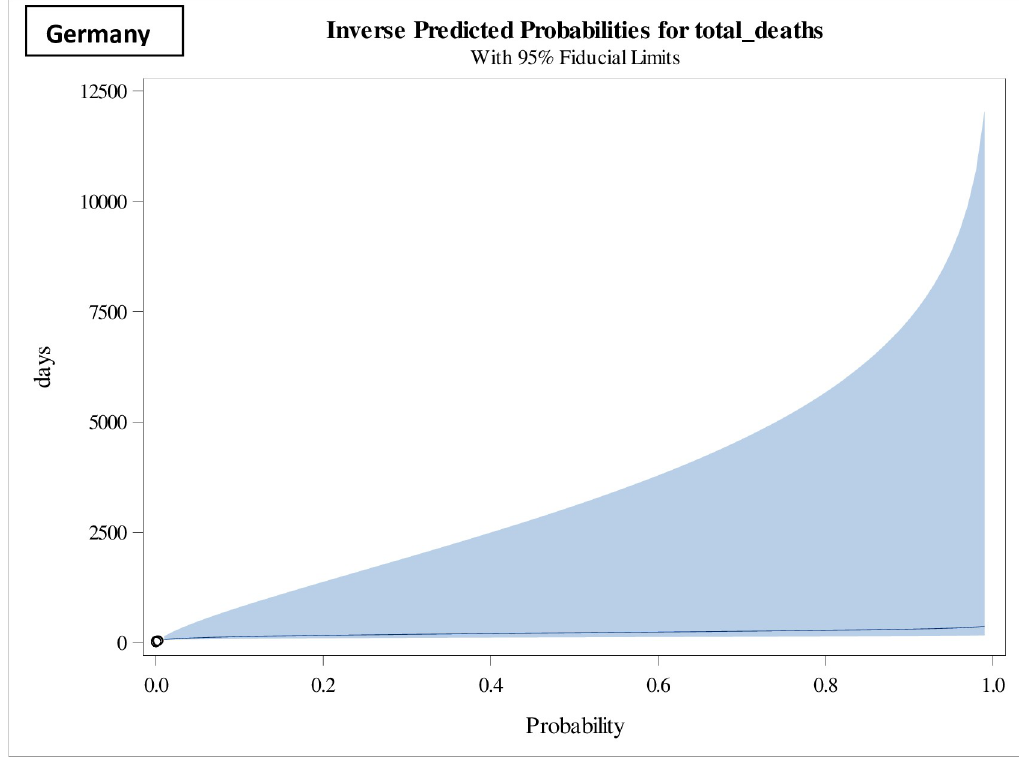
Fig 2. Inverse predicted probabilities of total deaths in Germany of Category I having Class 1 (0.01–0.05) mortality rates.